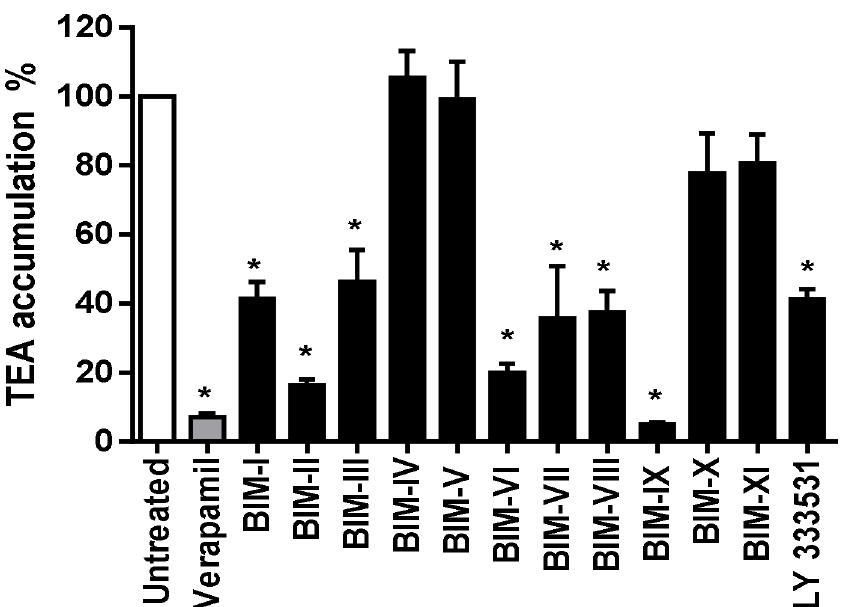
Fig 6. Inhibition of OCT1 activity by various BIM-related molecules. HEK-OCT1 cells were incubated with 40 μ M [ 14 C]-TEA for 5 min at 37°C in the presence or absence of 50 μ M verapamil or of various BIMs, used each at 5 μ M. After washing with ice-cold PBS, intracellular accumulation of [ 14 C]-TEA was determined by scintillation counting. Data are expressed as % of accumulation of TEA found in control cells, set at 100%, and are the means ± SEM of three independent experiments. * , p < 0.05 when compared with untreated cells (ANOVA followed by Dunnett's post-hoc test).